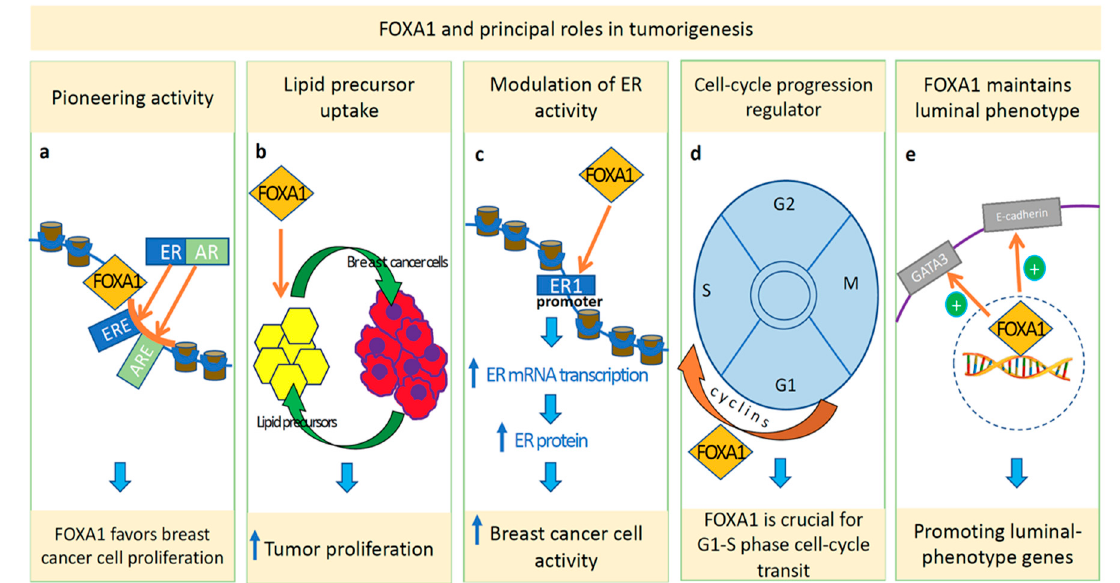
Figure 1. Graphical illustration of principal roles of FOXA1 in tumorigenesis that include pioneering activity ( a ), lipid-precursor uptake ( b ), modulation of estrogen-receptor (ER) activity ( c ), regulation of cell-cycle progression ( d ), and maintenance of expression of luminal-specific genes ( e ).